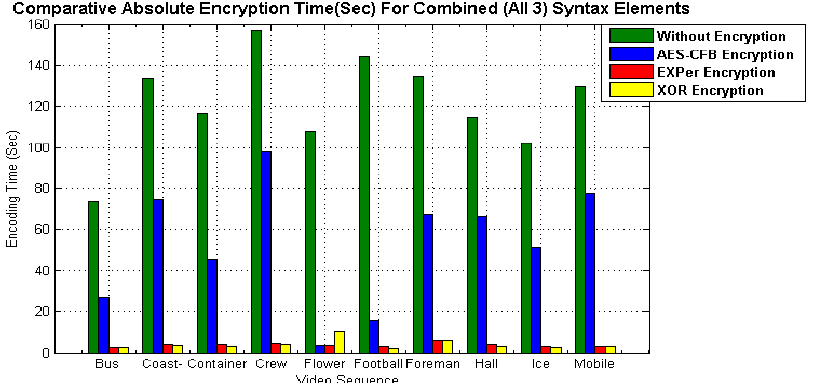
Figure 11. Comparative absolute encoding time of EXPer with AES-CFB and XOR.